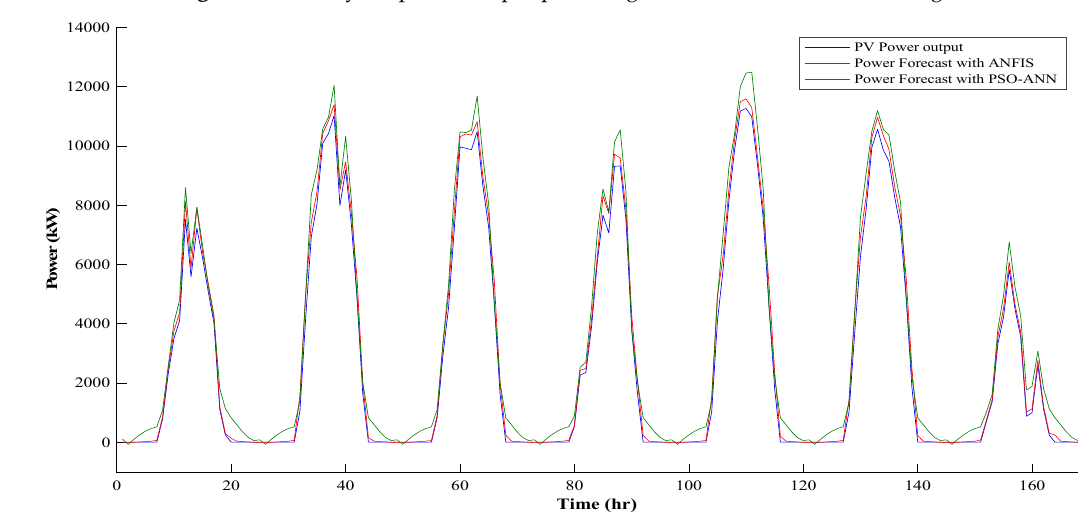
Figure 19. Comparison of PV power output forecasting.